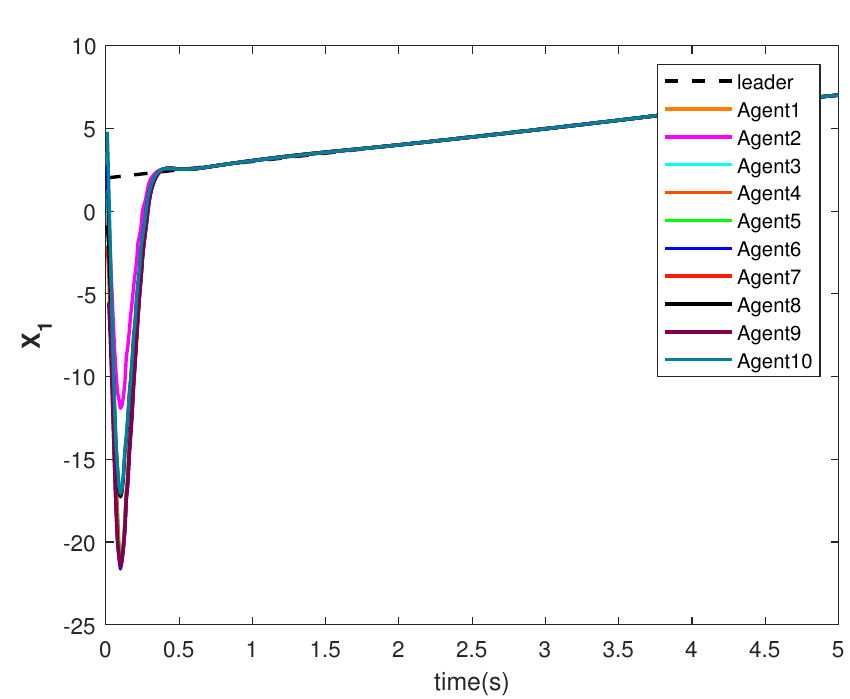
Figure 3. Consensus tracking of state X 1 of the